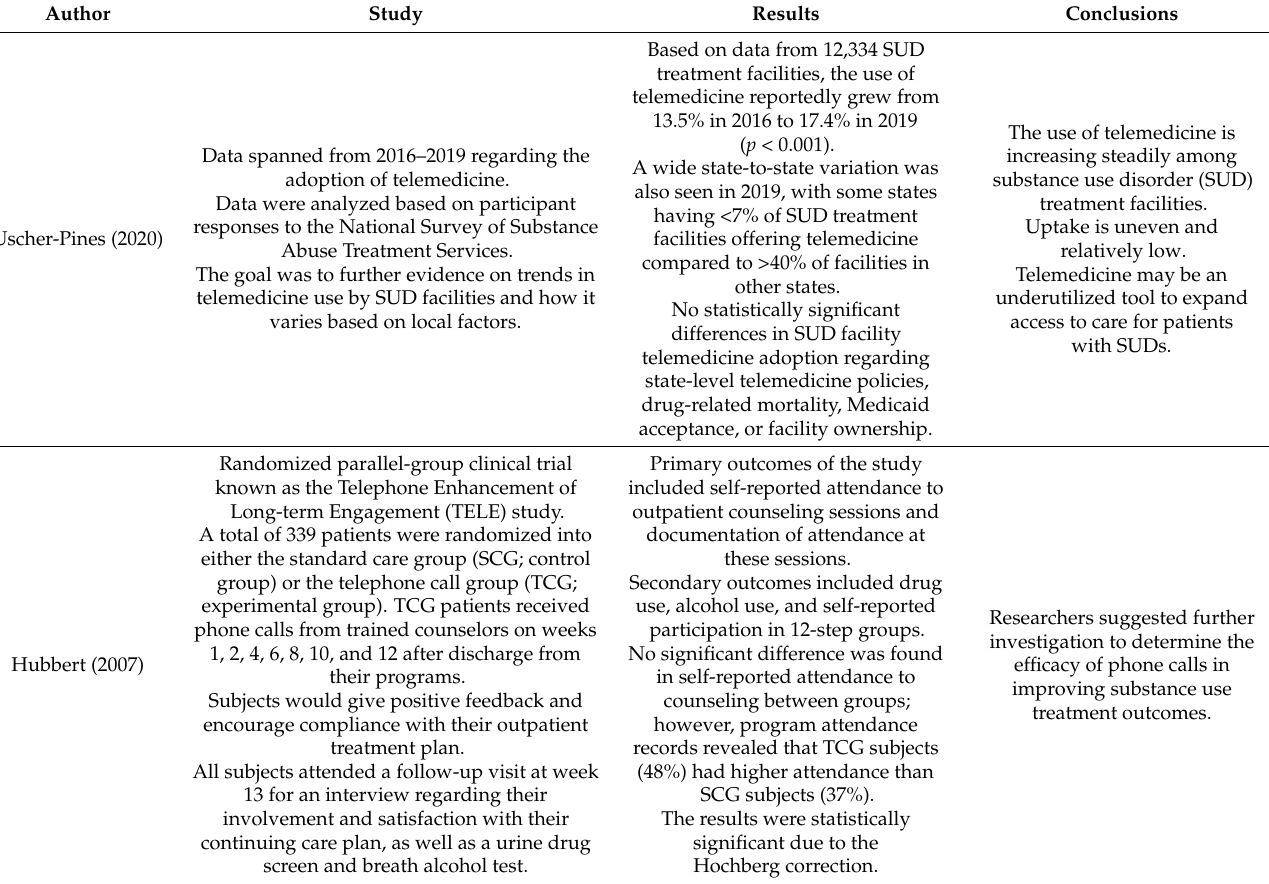
Table 1. Clinical studies regarding the use of telehealth modalities in substance use